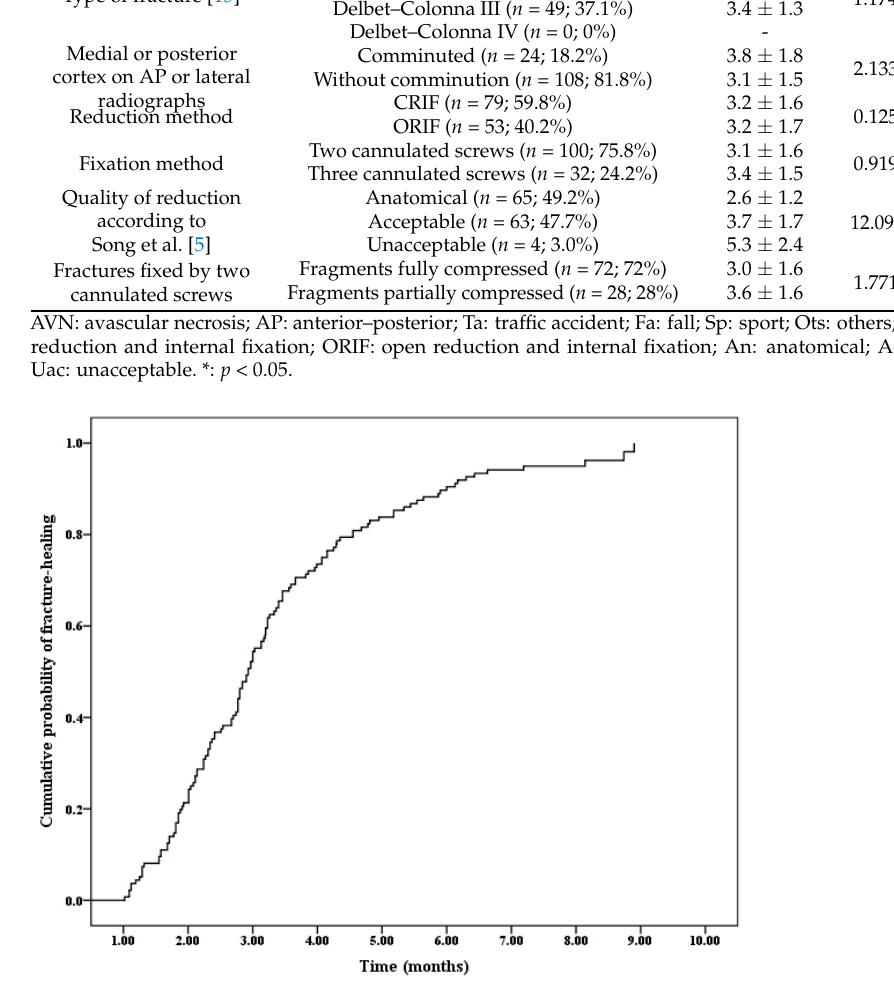
Figure 4. Overall probability of achieving fracture healing according to the Cox regression analysis. Table 1. Time needed to achieve fracture healing according to the demographics of the patients.